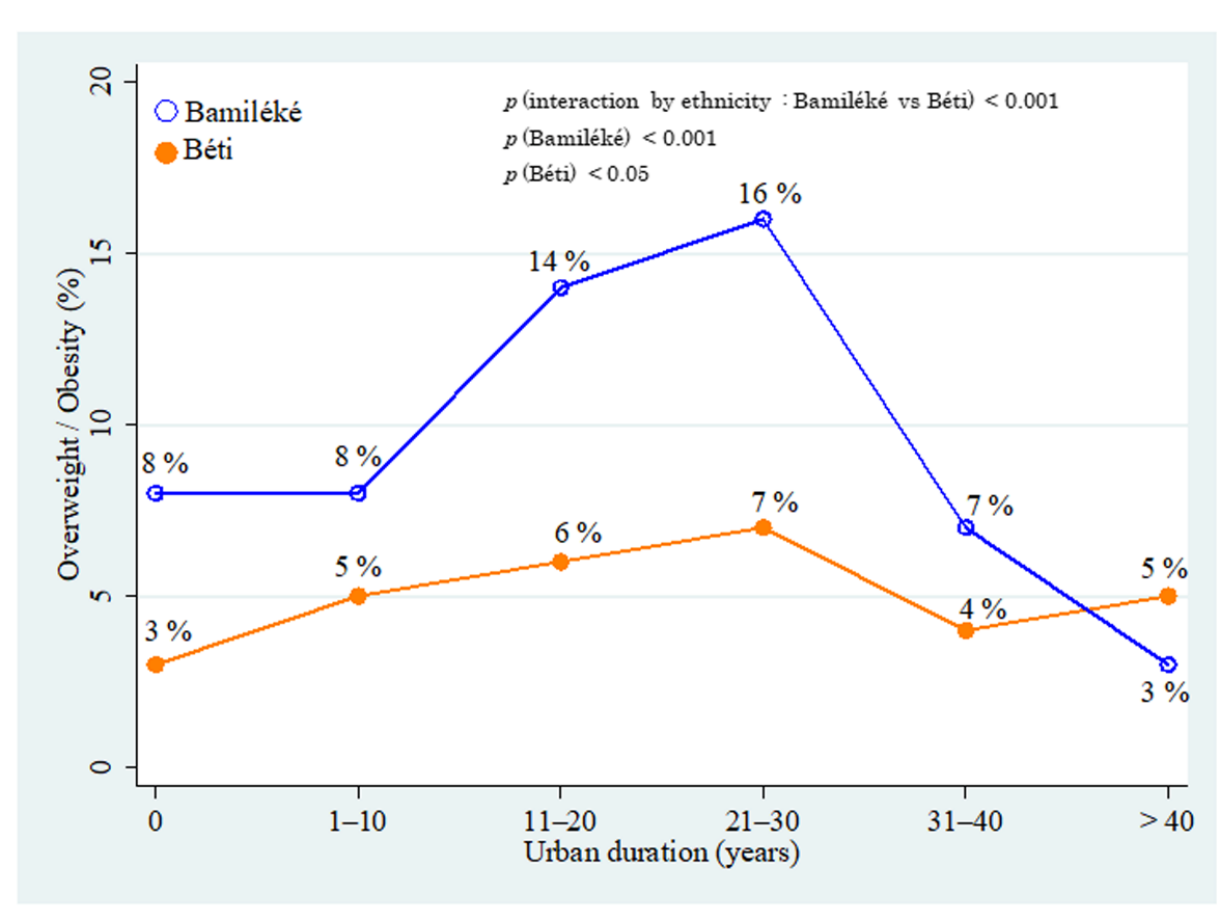
Figure 3. Association between the prevalence of overweight and migration status in Béti and Bamiléké, adjusted by age. The respective original value of each prevalence in Bamiléké was: 8% ( n = 41); 8% ( n = 47); 14% ( n = 81); 16% ( n = 95); 7% ( n = 44); and 3% ( n = 20). The respective original value of each prevalence in Béti was: 3% ( n = 12); 5% ( n = 26); 6% ( n = 30); 7% ( n = 40); 4% ( n = 21); and 5% ( n = 30). The p values to test the differences between Bamiléké and Béti (ethnicity), and the differences among Bamiléké and Béti are presented in the upper right.